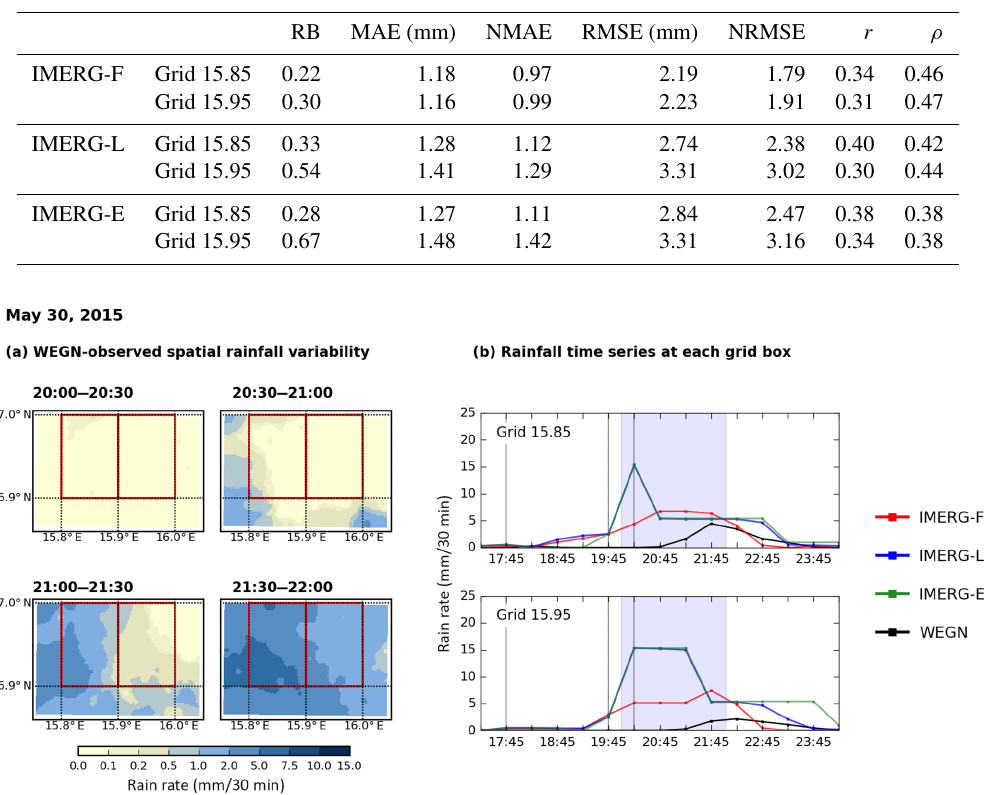
Figure 7. Example rainfall event in the warm season that occurred on 30 May 2015. (a) Spatial rainfall pattern over the WEGN network for consecutive half-hourly periods over the two selected IMERG grid boxes (red outline; see Fig. 1). (b) Time series of IMERG-F, IMERG-L, IMERG-E estimates, and WEGN data in each grid box during the rainfall event, with the shaded areas highlighting the two hours illustrated by the map sequence in (a) . Solid vertical lines indicate time steps where all three IMERG runs received PMW-based information for the rainfall retrieval at that time step, dotted vertical lines (not applicable for this event but for the event of Fig. 8 below) mean that either IMERG-E or both IMERG NRT runs did not receive PMW-based information at the time step, and no vertical line (the case for most time steps) implies that none of the IMERG runs received PMW-based